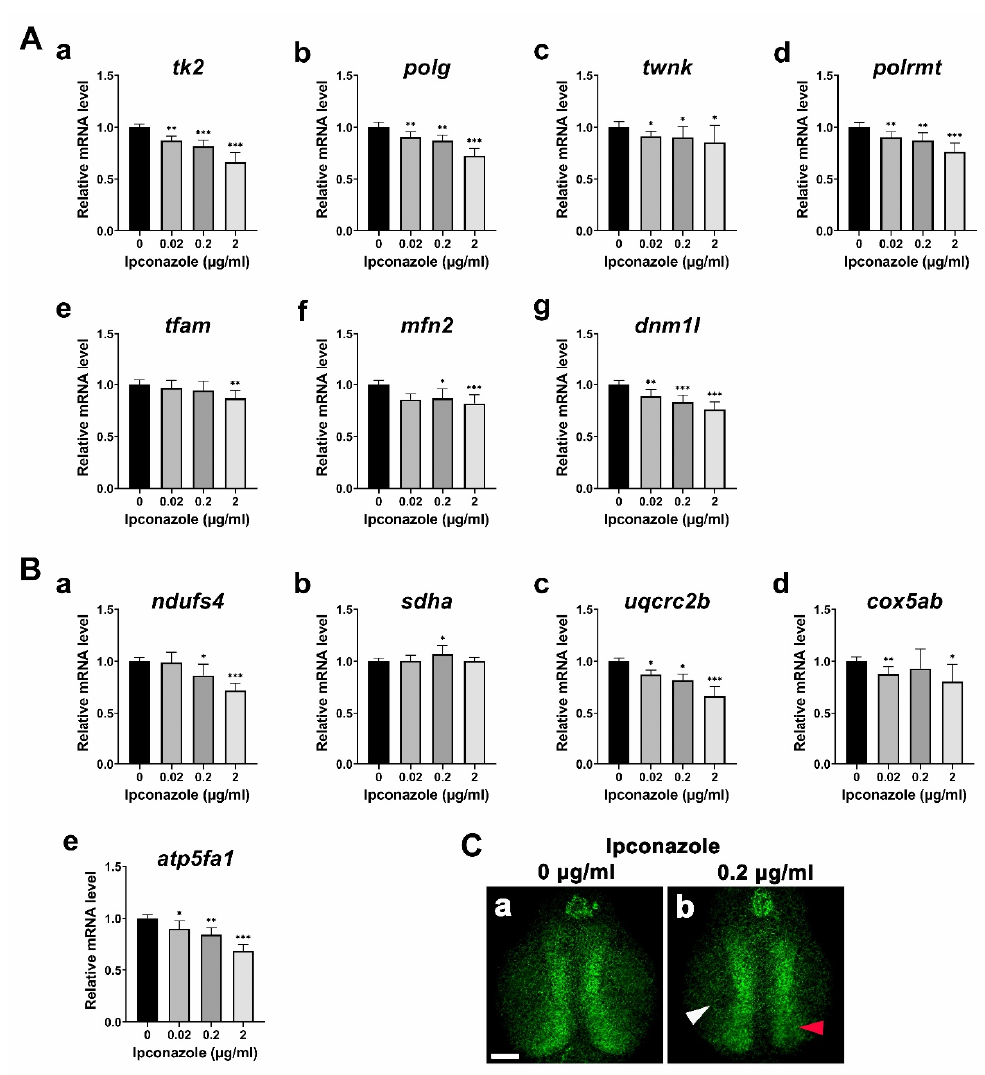
Figure 2. Ipconazole disrupts mitochondrial genome maintenance and respiratory complexes. ( A ) mRNA profiling of the genes involved in the mitochondrial DNA replication and transcription , tk2